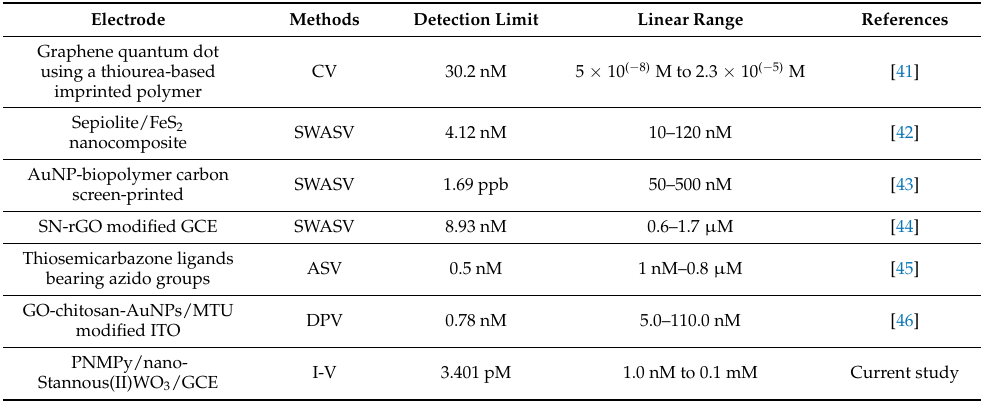
Table 2. Comparison of Hg(II)-selective PNMPy/nano-Stannous(II)WO 3 /GCE modified GCE with other Hg (II)-selective